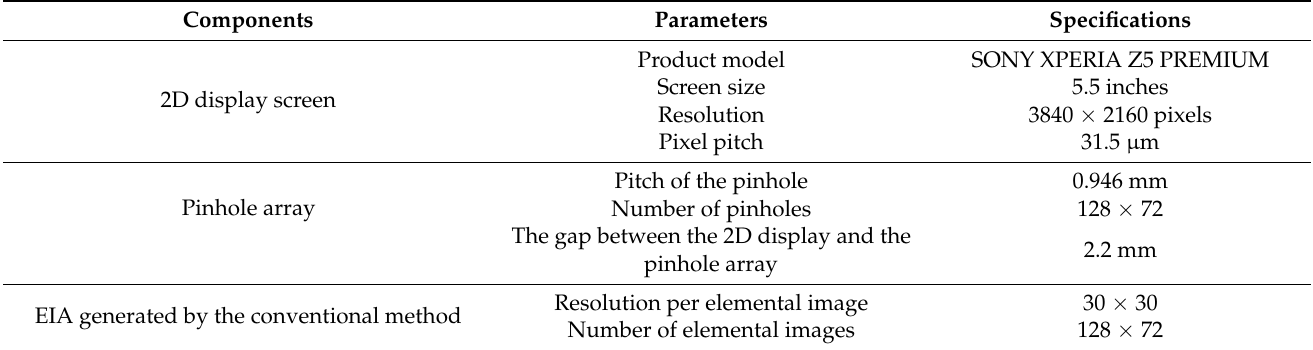
Figure 7. Configurations of the experiment. ( a ) 3D display prototype; ( b ) 3D scene created in software 3ds Max. Table 1. Configurations of the